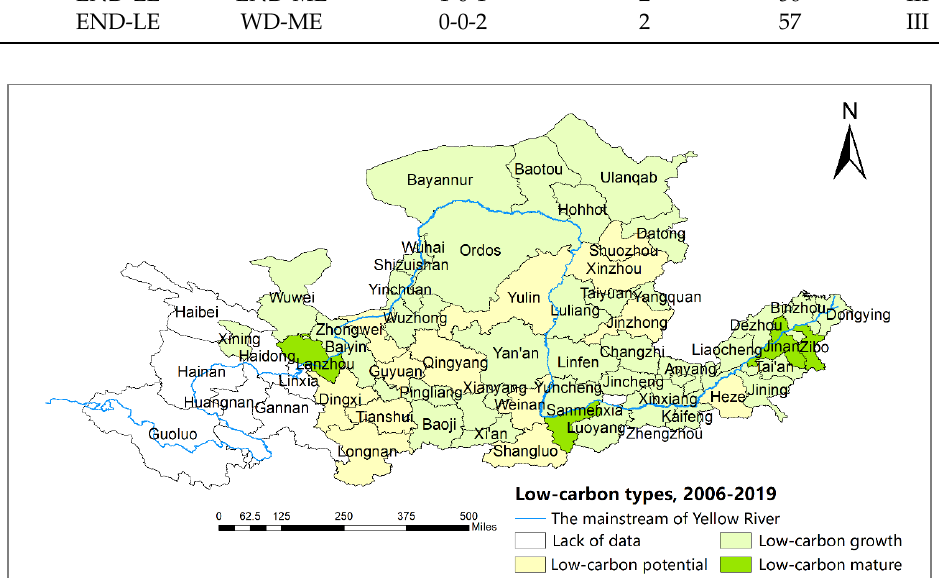
Figure 5. Low-carbon types of cities in the YRB by total score, 2006 – 2019.